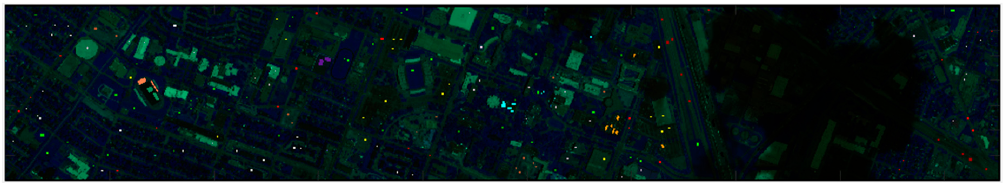
Figure 1. RGB values in tandem with the ground truth pixel values. Table 1. Number of pixels per class in the IEEE Geoscience and Remote Sensing Society (GRSS) data. Total number of unlabeled pixels is 649816 and total number of pixels is 664845. Class Samples Name Number Color Legend